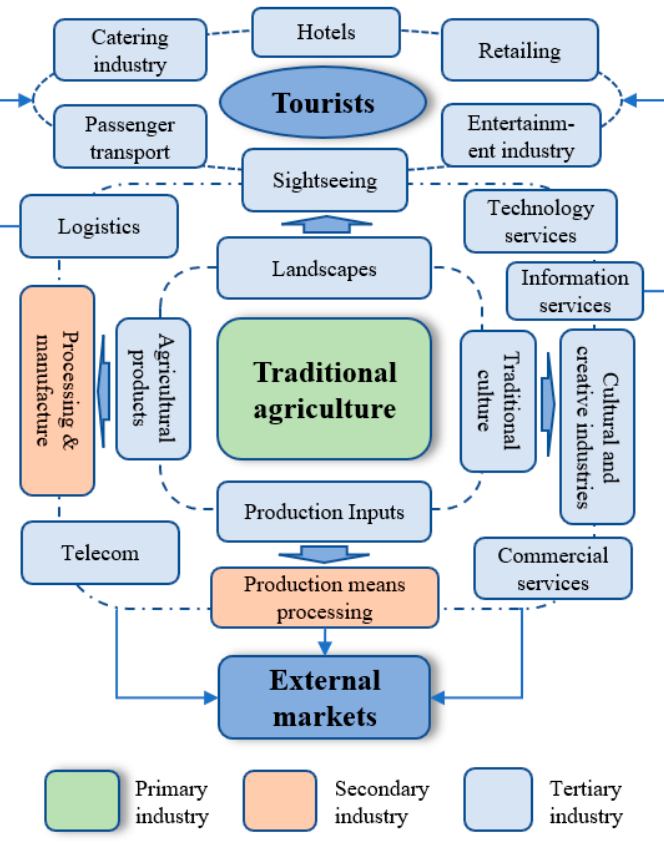
Figure 2. Industrial system in IAHS sites.